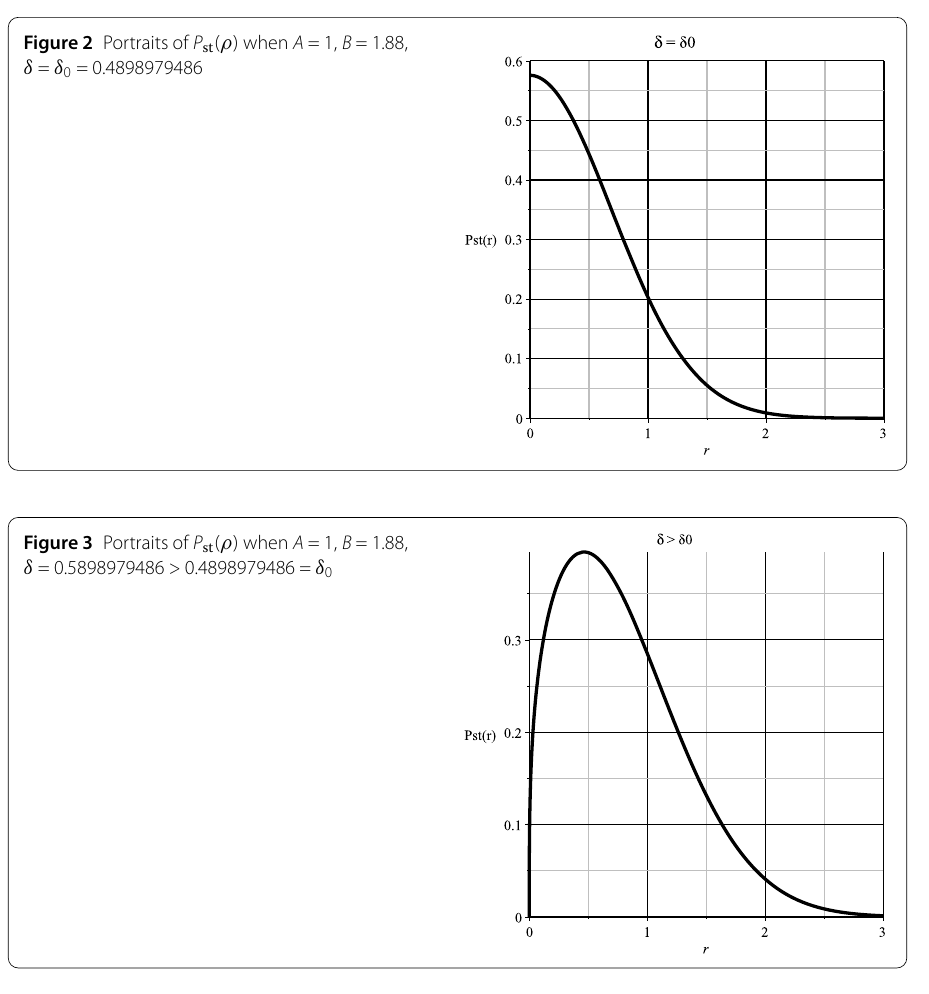
Figure 2 Portraits of P st ( ρ ) when A = 1, B = 1.88, δ = δ